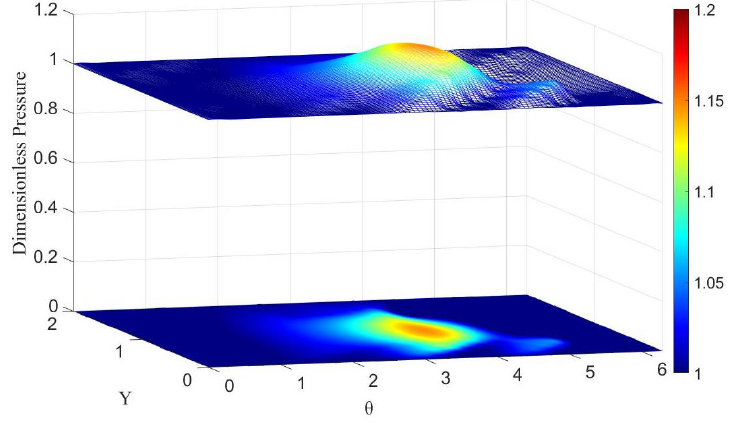
Figure 4. Dimensionless pressure field of hydrogen gas bearing (0.5 MPa, 300 K).